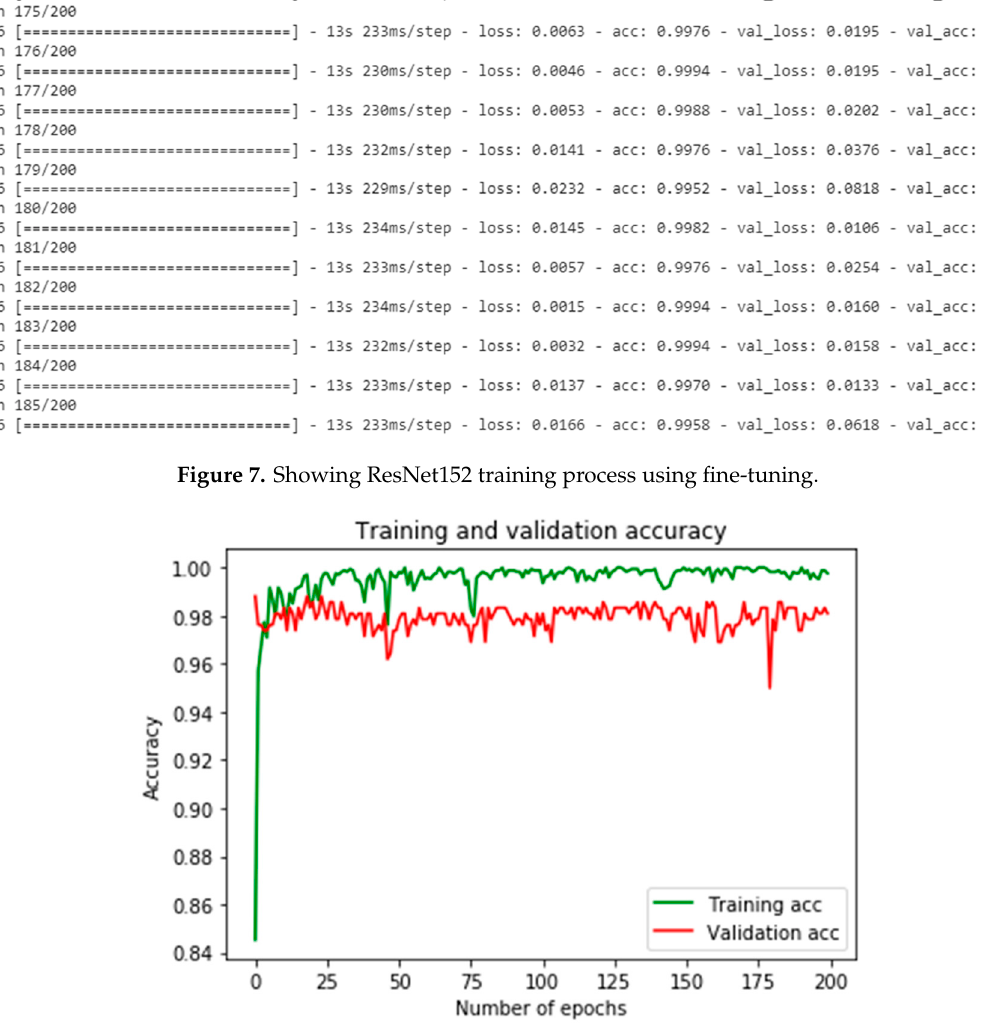
Figure 8. Showing training and validation accuracies using ResNet50 .